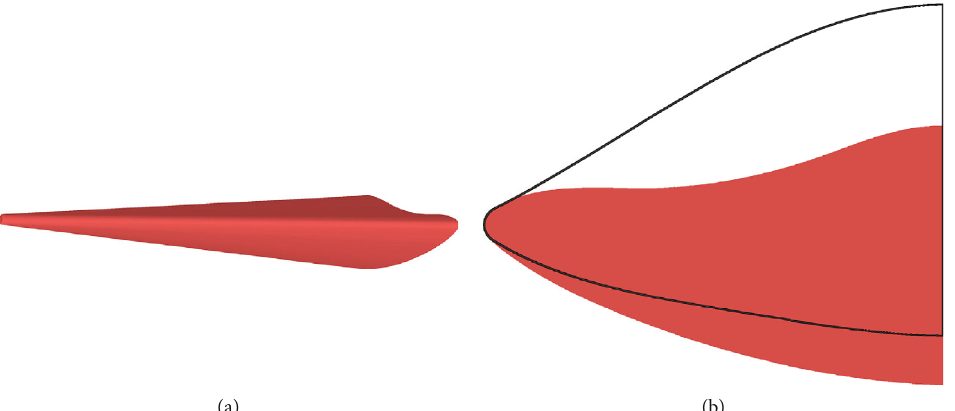
Figure 6: Typical con fi guration with high lift-to-drag ratio: (a) con fi guration and (b) after-body section compared with the baseline (black line).